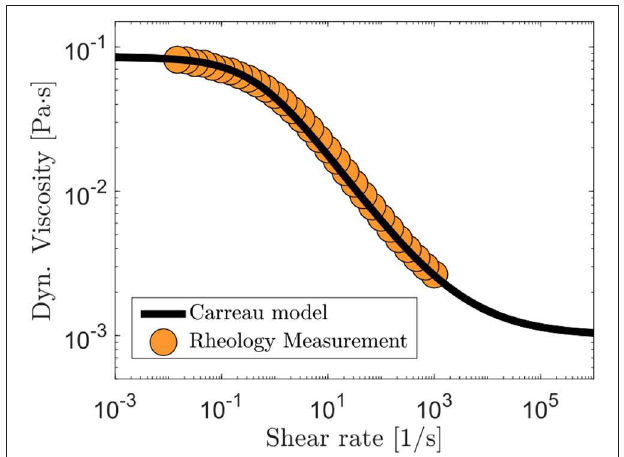
FIGURE 4 | Measured rheology of a 0.05 wt% xanthan gum solution, with the best fit of the Carreau model for the parameters: µ 0 0.085 Pa s, = · µ 0.001 Pa s, λ 2 s, n 0.48 and α 0.8. Very high shear rates have · = = = ∞ = not been measured. Literature values indicate that